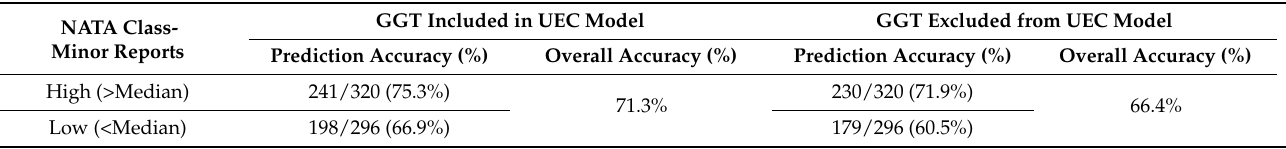
Table 3. The impact of GGT on the Electrolyte-Creatinine EQA model of NATA class prediction by random forest modelling. NATA Class- Minor